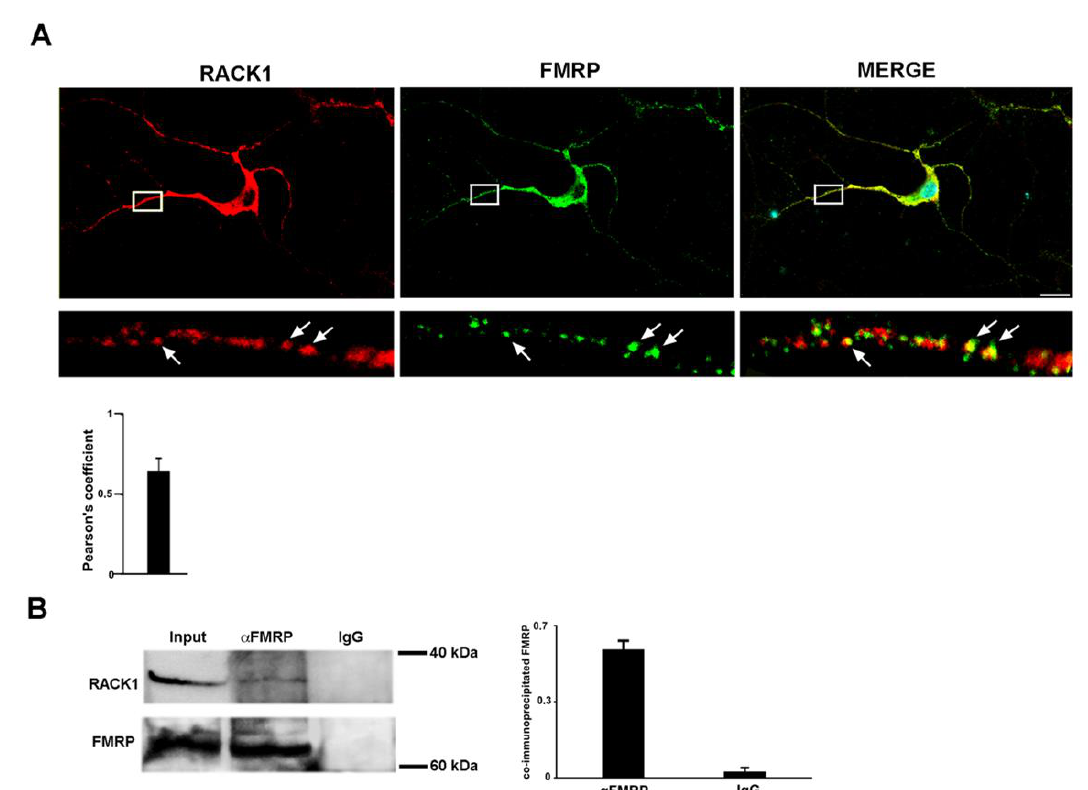
Figure 5. RACK1 and FMRP are part of the same complex. ( A ) RACK1 (red) and FMRP (green) in immunofluorescence experiments co-localize in the soma and partially along neurites of mouse embryonic hippocampal neurons. Inbox, the magnification of one neurite; the arrow indicates the granules where there is colocalization between RACK1 and FMRP. Scale bar: 10 µ m. Bar grapgh reproteing the Pearson’s coefficient of puncta along between RACK1 and FMRP measured by immunofluorescence experiments. The bar represents mean ± SD; n.70 puncta from three independent experiments. ( B ) Western blotting on eluted protein by RACK1-FMRP co-immunoprecipitation assay from mouse brain. Rabbit IgG was used as a negative control of co-immunoprecipitation. The images are representative of three independent experiments.